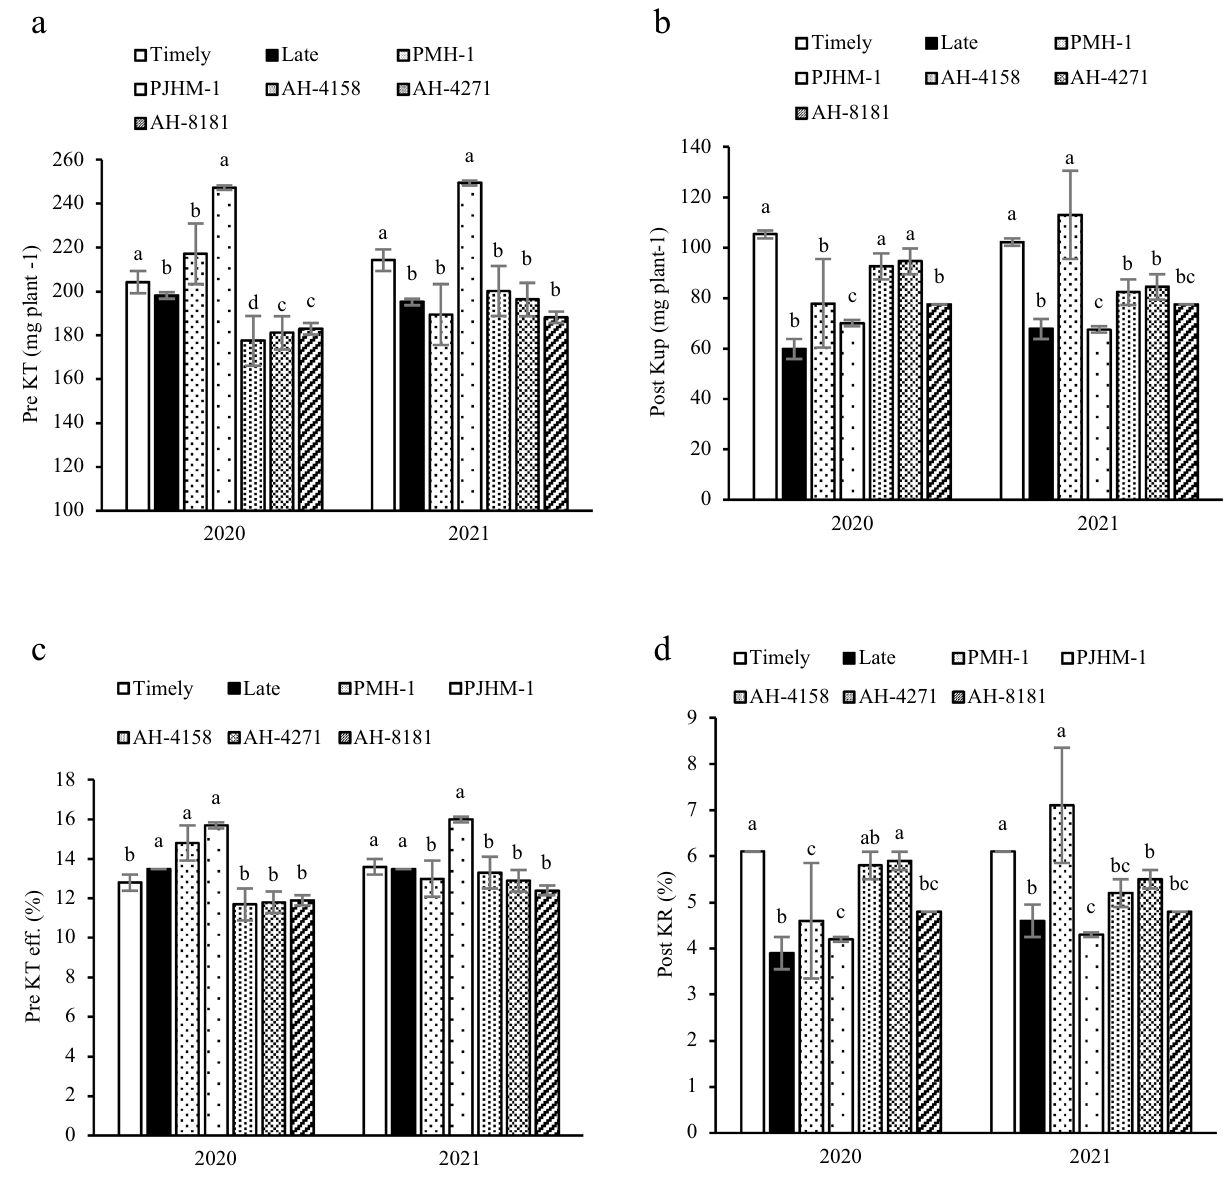
Figure 4. Pre KT- pre-anthesis potassium translocation ( a ), Post KuP- post-anthesis potassium uptake ( b ), Pre KT-eff.- pre-anthesis potassium translocation efficiency ( c ), Post KR- ratio of post-anthesis K uptake to total K accumulation ( d ). Within years, sowing time, and genotypes, different letters on the individual bars of a figure indicate significant difference ( p ≤